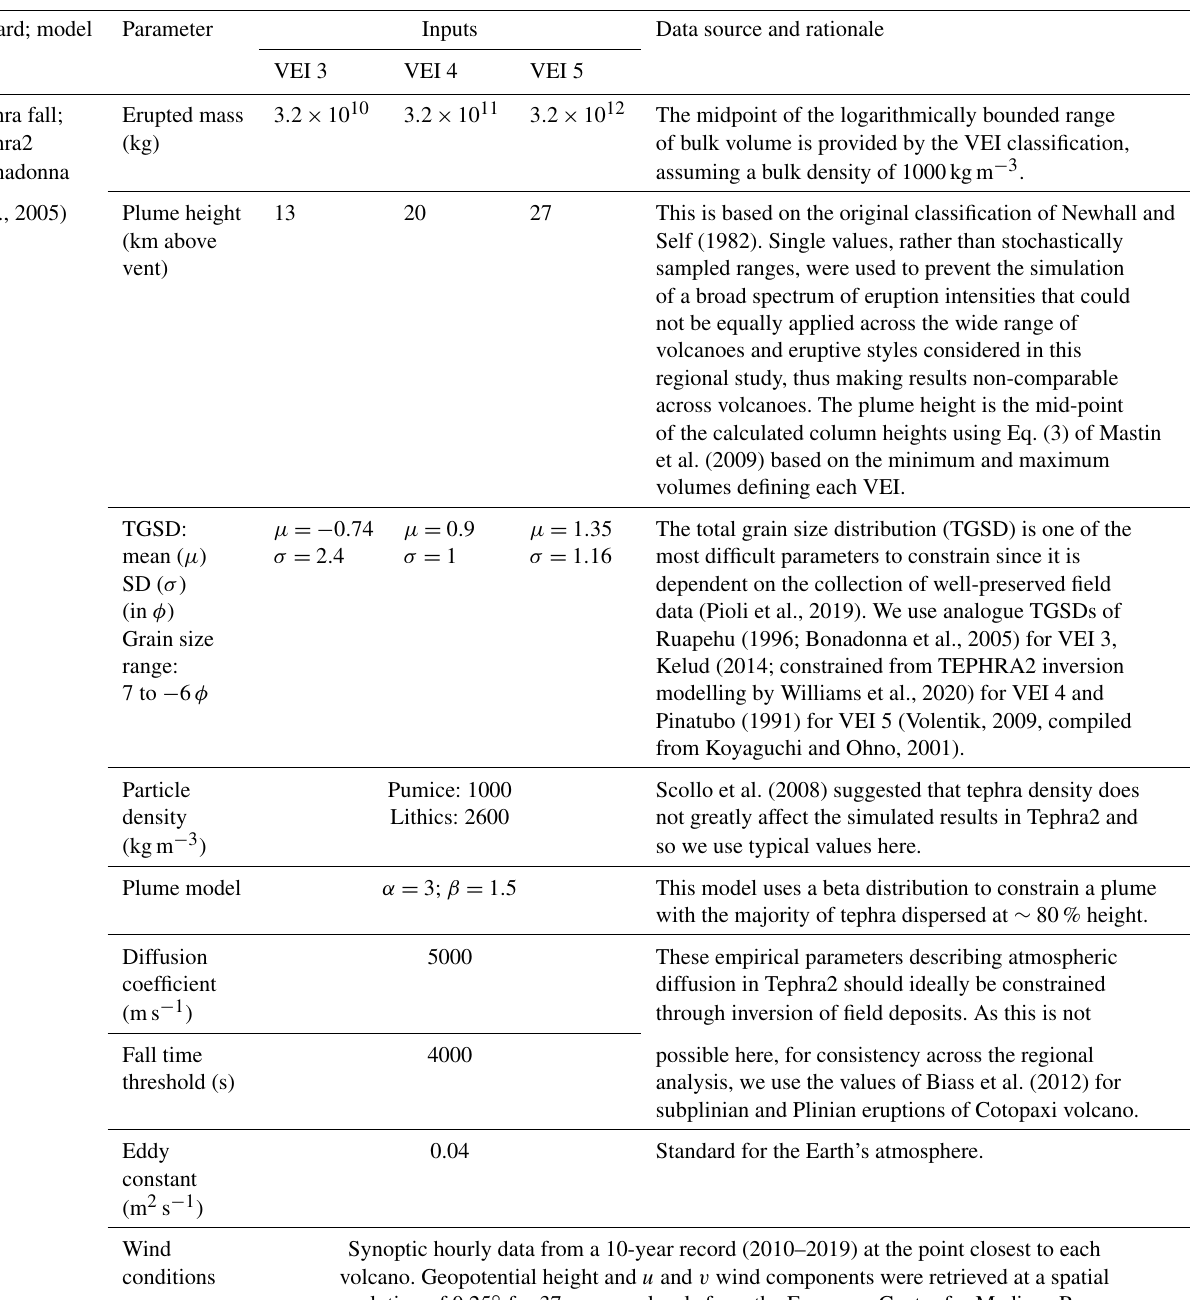
Table A1. Model input parameters and their rationale used for simulating tephra dispersion and